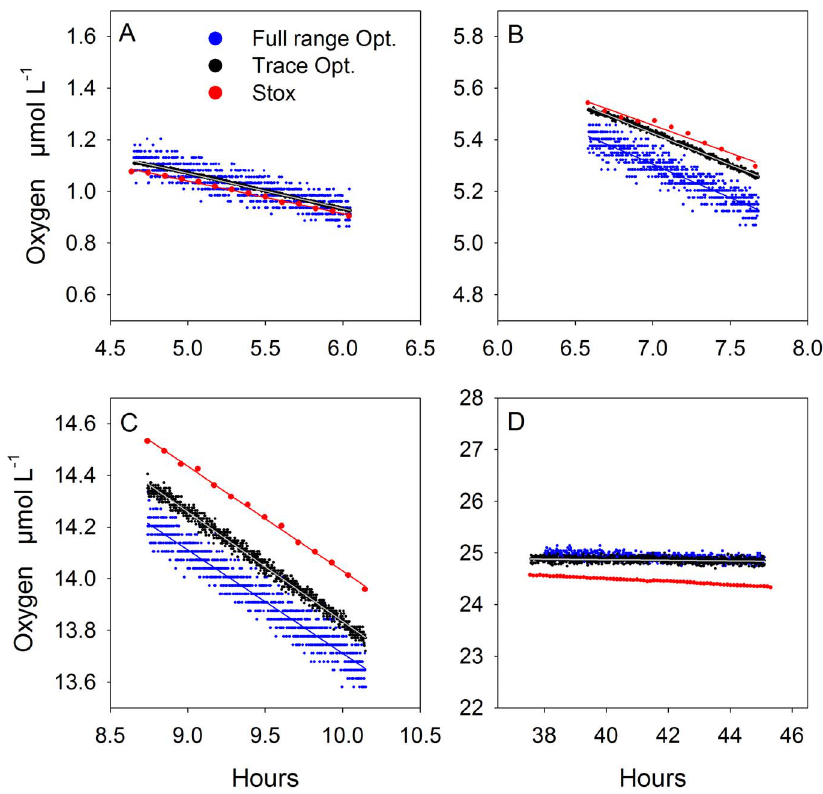
Figure 4. Experiment 1: Comparison of O 2 decrease over time. The O 2 consumption measured by optodes and STOX sensor after the adjustment to O 2 concentrations of 1.2 m mol L 2 1 (A), 5.5 m mol L 2 1 (B) and 14.3 m mol L 2 1 (C), and after the addition of 20 ml ZnCl 2 (D). Linear fits are indicated by the straight lines. Please note, the aspect ratio of time and concentration axis ( m mol L 2 1 to hour) is the same for all figures to allow comparison of slopes.